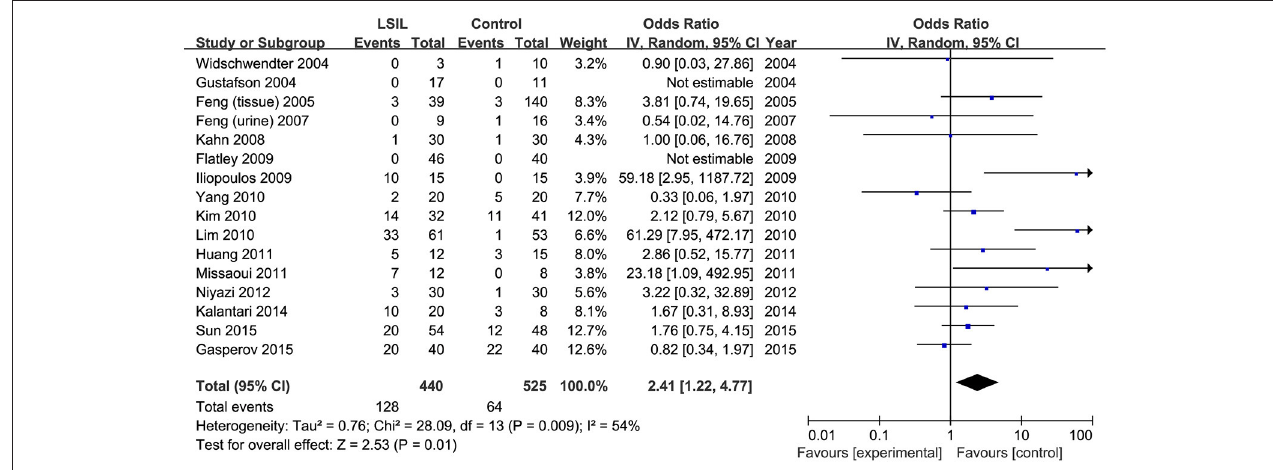
FIGURE 2 | Funnel plots for the associations of DAPK1 promoter hypermethylation with the risk of LSIL. The squares represent the ORs for individual studies. The size of the square reflects the weight of included studies. Bars represent the 95% confidence intervals (CIs). The center of the diamond represents the summary effect size. LSIL, low-grade intra-epithelial lesion.